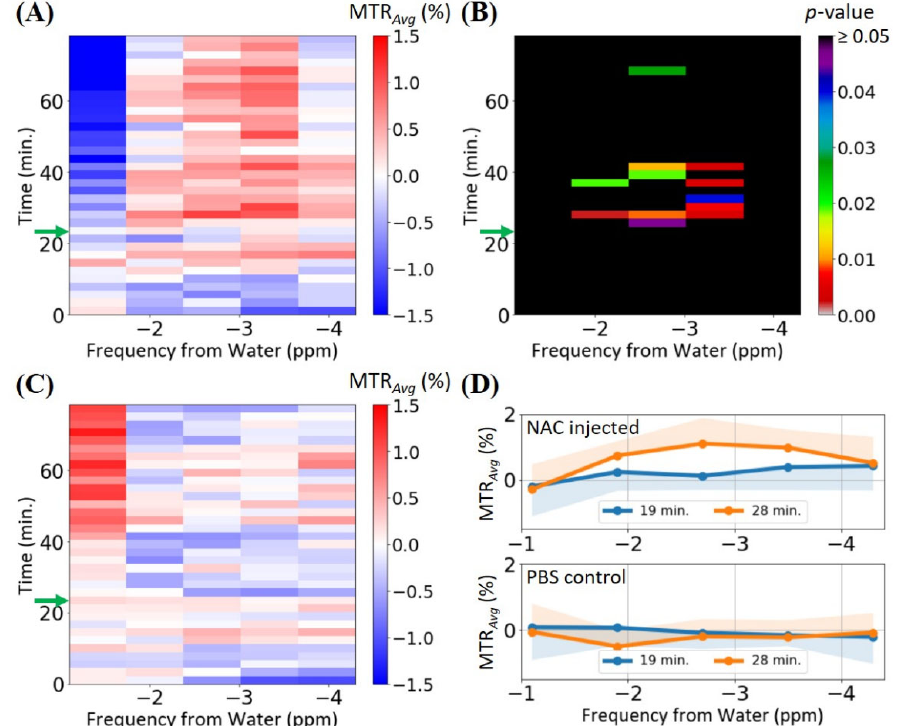
Figure 4. The partial Z ‐ spectral ( − 4.3– − 1.1 ppm) data for the test ( n = 5) and control ( n = 5) mouse groups. ( A ) A 2D map showing the MTR Avg magnitudes for the test group as a function of chemical shift from water and experimental time. ( B ) A 2D map showing the experimental time and chemical shift regions where the test group’s MTR Avg values were statistically different from the control group’s MTR Avg values with p < 0.05 (Welch’s t ‐ test). ( C ) A 2D map showing the MTR Avg magnitudes